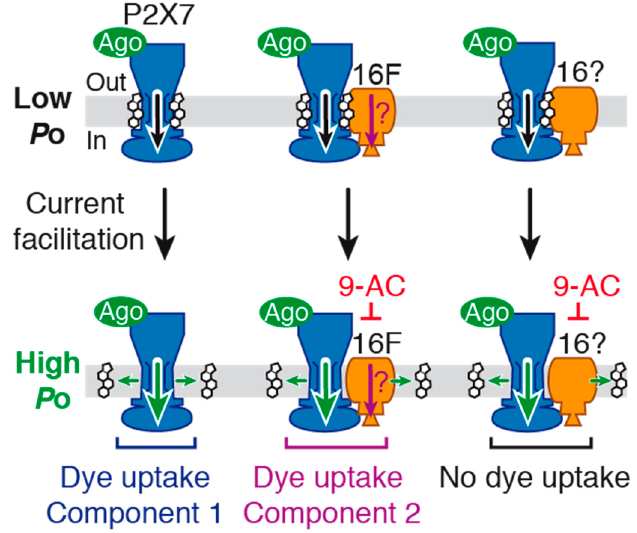
Figure 8. Proposed mechanisms underlying P2X7 current facilitation and macropore formation. P2X7 (blue) and TMEM16F (16F, orange) form functional complexes, in which both proteins are close to each other. In response to brief application of agonist (Ago, green spheres), cholesterol (hexagonal rings) maintains functional complex-embedded P2X7, and possibly “free” P2X7, in a low channel activity state (black arrows). Long or repeated agonist application transitions P2X7 channels from a low to high P o (enlarged green arrows), presumably through cholesterol dissociation (small lateral green arrows). Meanwhile, agonist binding to P2X7 activates at least two permeation components for large molecules, one that occurs directly through the P2X7 pore (component 1), and the other through functional coupling to TMEM16F (16F) (component 2). Note that the precise dye uptake pathway of component 2 (purple arrows) is unknown. Functional coupling with another TMEM16 subtype of unknown composition is also suggested. Membranes are represented as grey shadings. 9-AC (9-anthracene-carboxylic acid) is a non-selective TMEM16 inhibitor. See text for details.